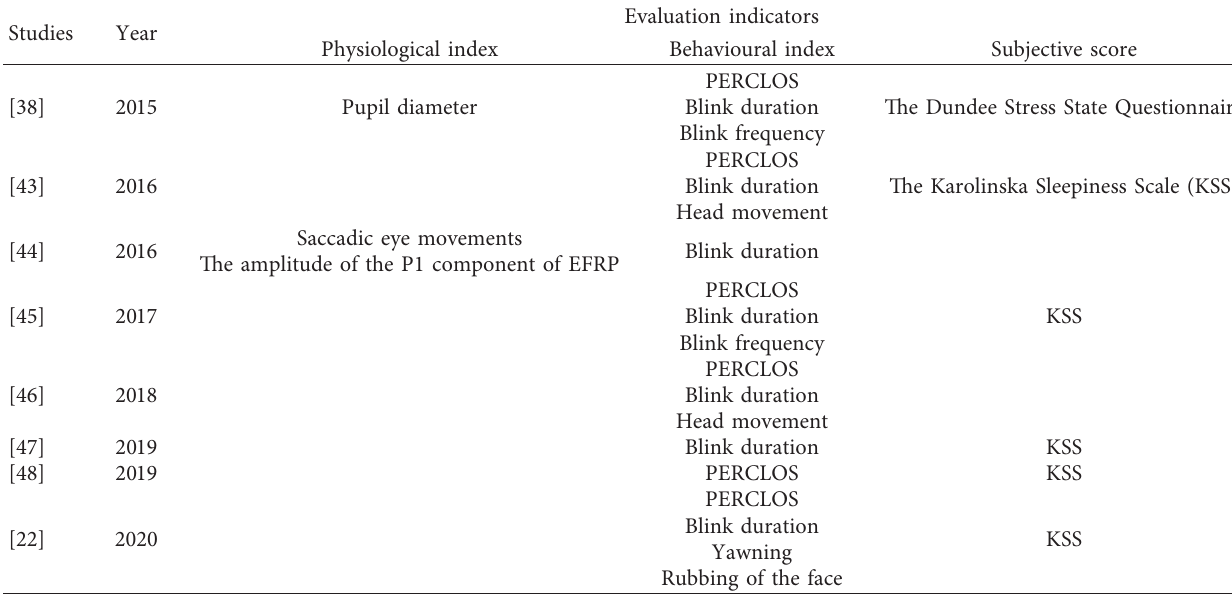
Table 1: Evaluation indicators of automated driving